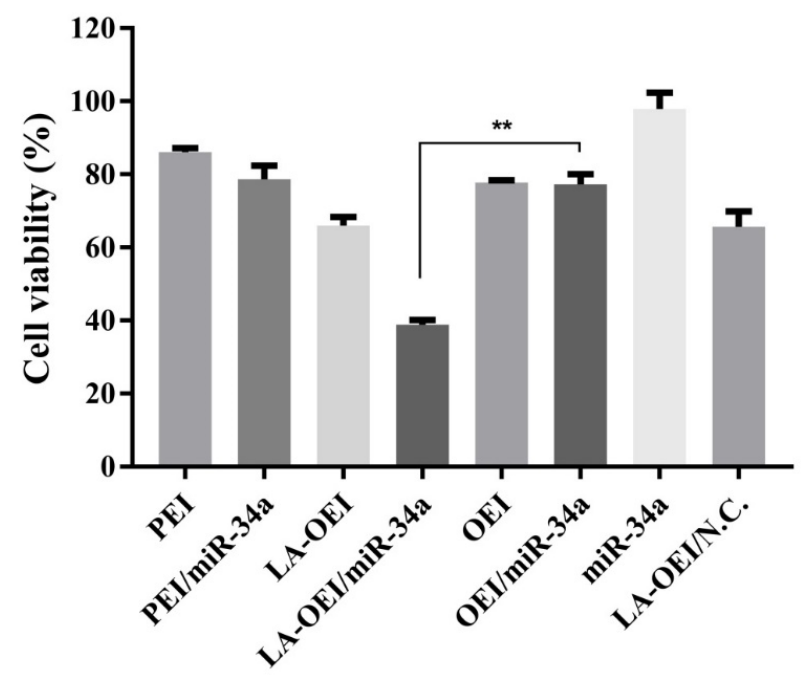
Figure 4. The anti-proliferative effect of HeLa cells after the treatment with different nanoparticles. Data were presented as the mean value ± SD of triplicate experiments (** p < 0.01). Except for the cell apoptosis, the arrest of cell cycle was another important reason leading to the inhibition of cell proliferation. Compared to the control group, a large population of cells could be arrested at G1 phase after the miR-34a transfection, suggesting the effective arrest of cell cycle at G1 phase (Figure 7 and Figure S10). In particular, the G1 phase ratio of 82.50% was obtained for the LA-OEI/miR-34a nanoparticles, which was much higher than the miR-34a transfection by PEI (78.30%) and OEI (74.58%). Meanwhile, there was no significant improvement of G1 phase ratio in free miR-34a and LA-OEI/N.C. This phenomenon probably relied on the reduced Cyclin D1 level after the miR-34a trans- fection (Figure 6), as Cyclin D1 was accepted to participate in the G1/S transition [38]. In summary, LA-OEI/miR-34a transfection could achieve a stronger anti-tumor